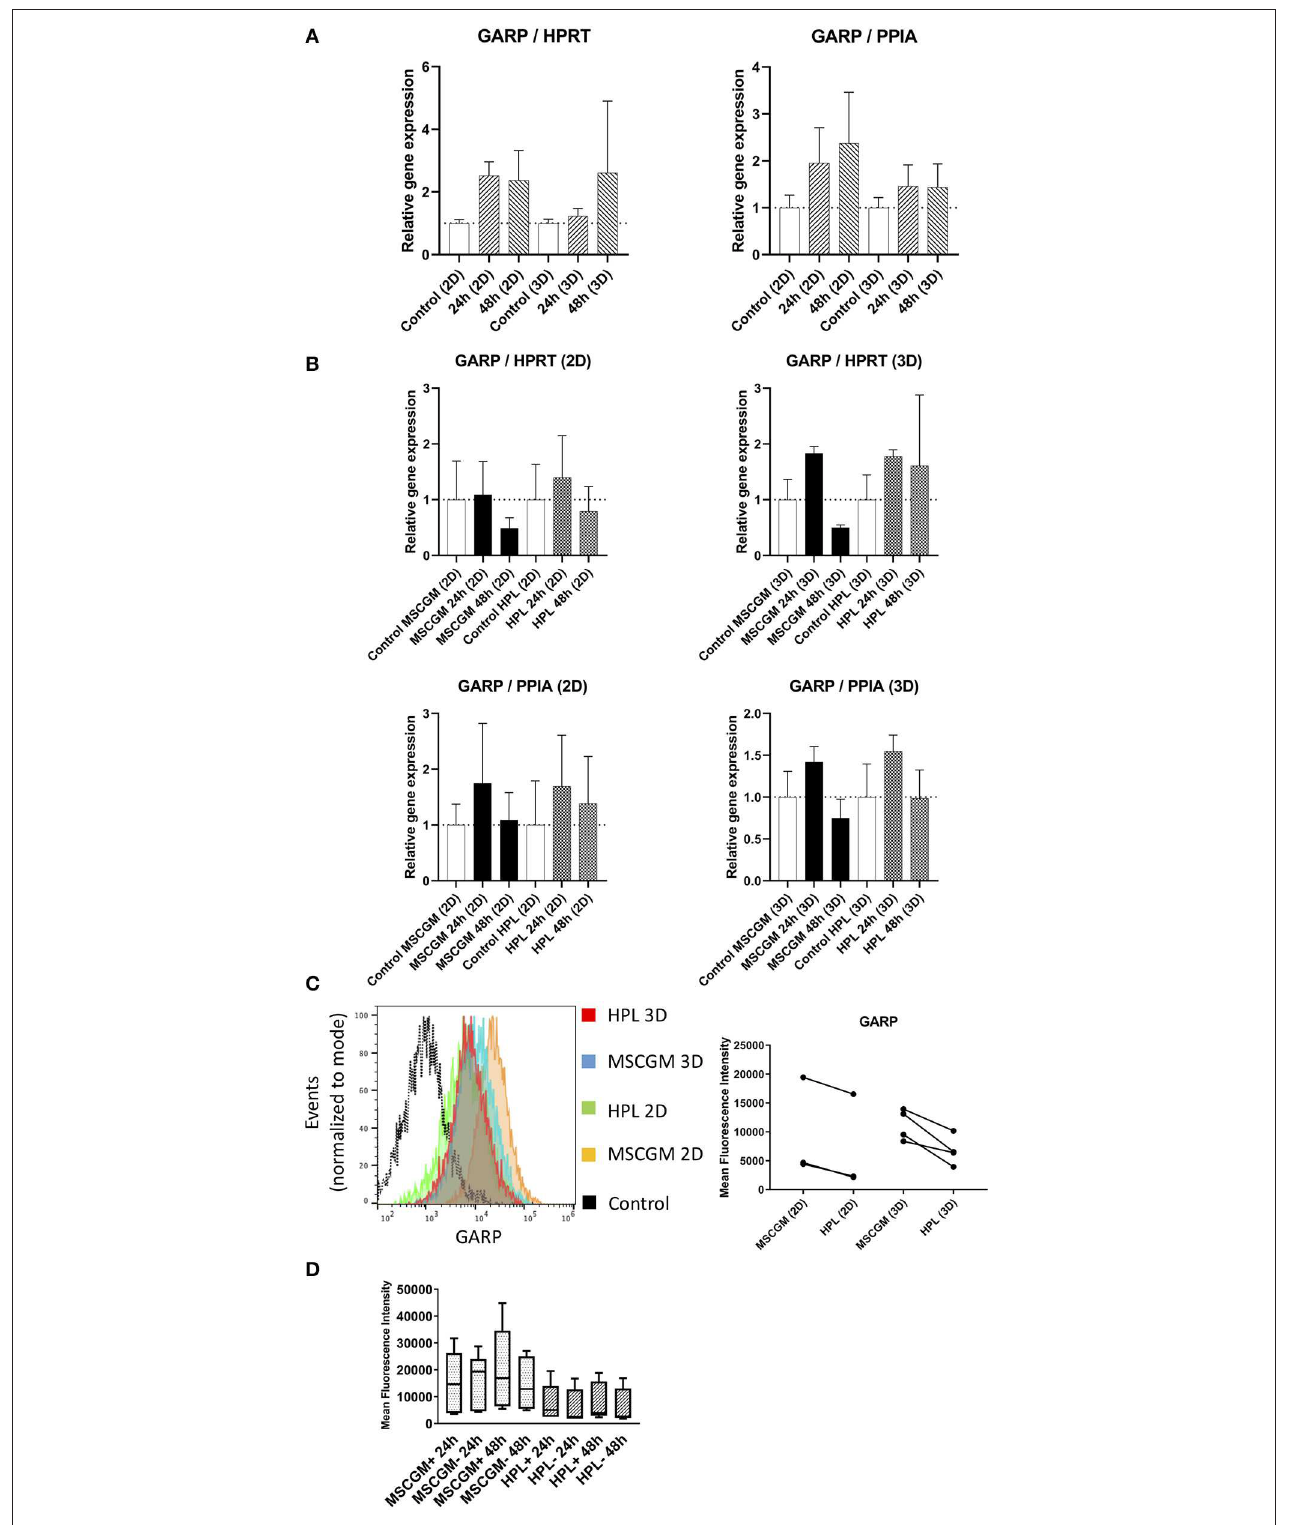
FIGURE 6 | Expression of the immunological molecule GARP. (A) Relative gene expression levels of GARP after 24 and 48h cultivation with MSCGM TM or MSCBM TM with 8% HPL and a control and a control at the beginning of cultivation time. Left: Normalized to the housekeeping gene HPRT (2D n = 5; 3D n = 3). Right: Normalized to the housekeeping gene PPIA (2D n = 5; 3D n = 3). (B) RT-PCR analysis of GARP gene expression in 2D and 3D MSCs for 24 and 48h stimulation